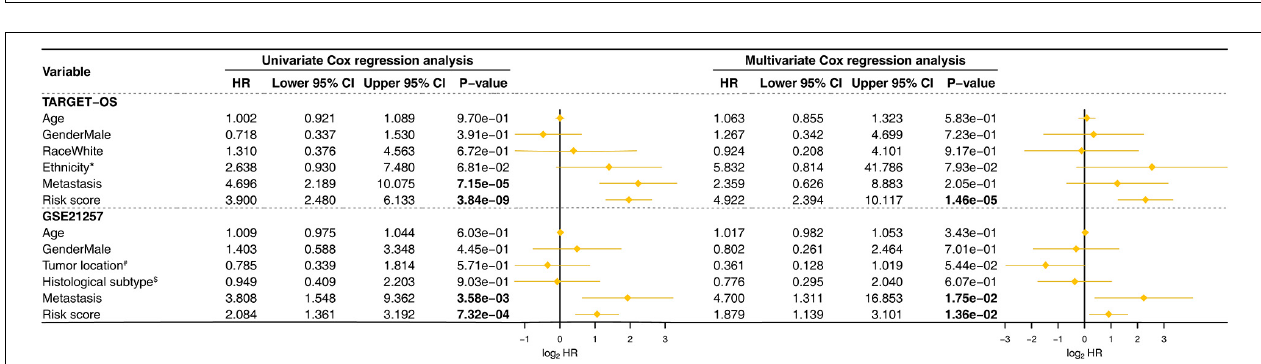
FIGURE 5 | Kaplan–Meier estimator evaluates the nine-gene signature’s prognostic capacity in the training (A) and validation (B) cohorts. The bottom parts indicate the number of patients at risk. The two-sided log-rank test measured the differences between the high- and low-risk groups with a p -value < 0.05.